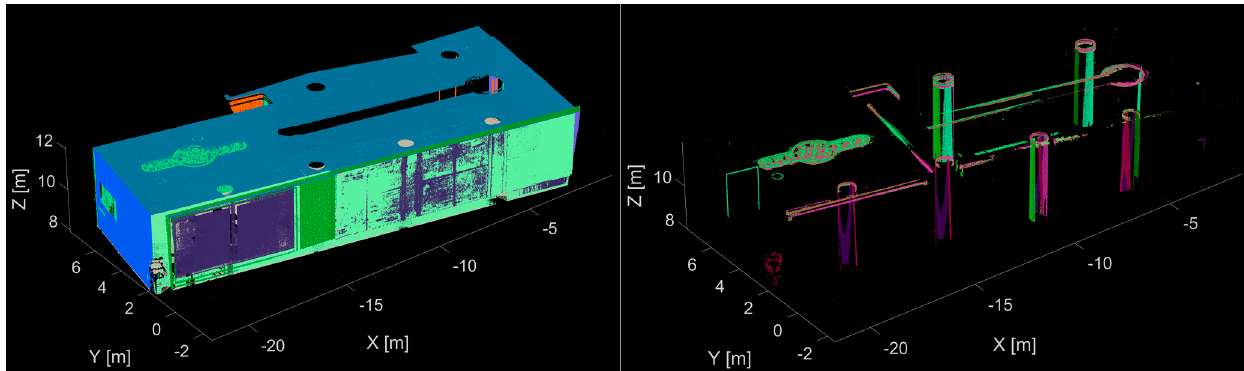
Figure 15. The plane segmentation result using the standard RANSAC algorithm in the case of a chosen room of the P.O. Hviezdoslavov Theater with the correctly segmented planes ( left ), and the incorrectly segmented planes ( right ).